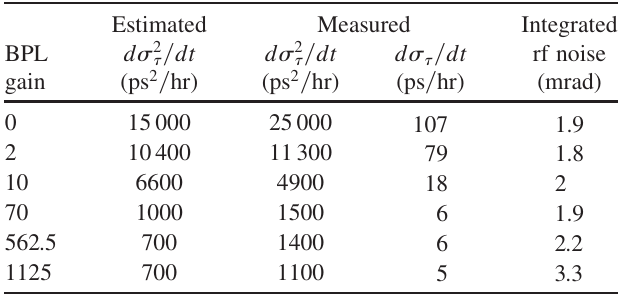
TABLE II. Bunch growth rate dependence on BPL gain and noise power for